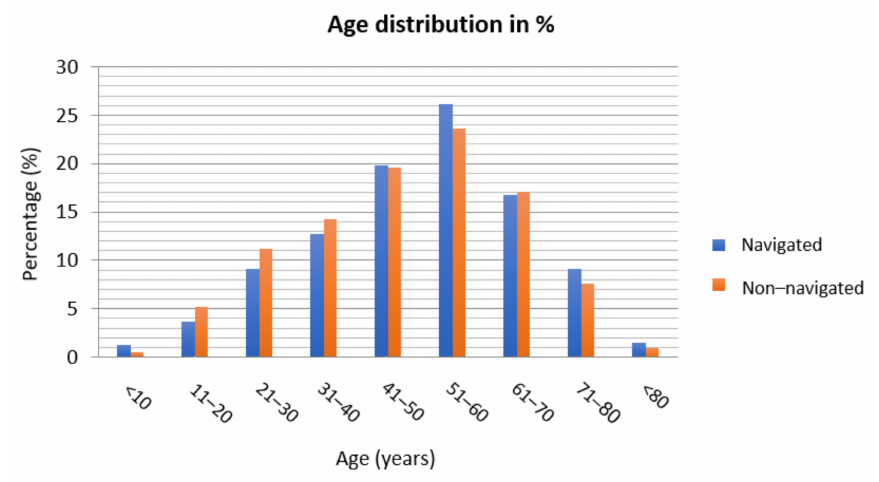
Figure 2. Age distribution of patients. Table 3. Case numbers, based on the seniority of the